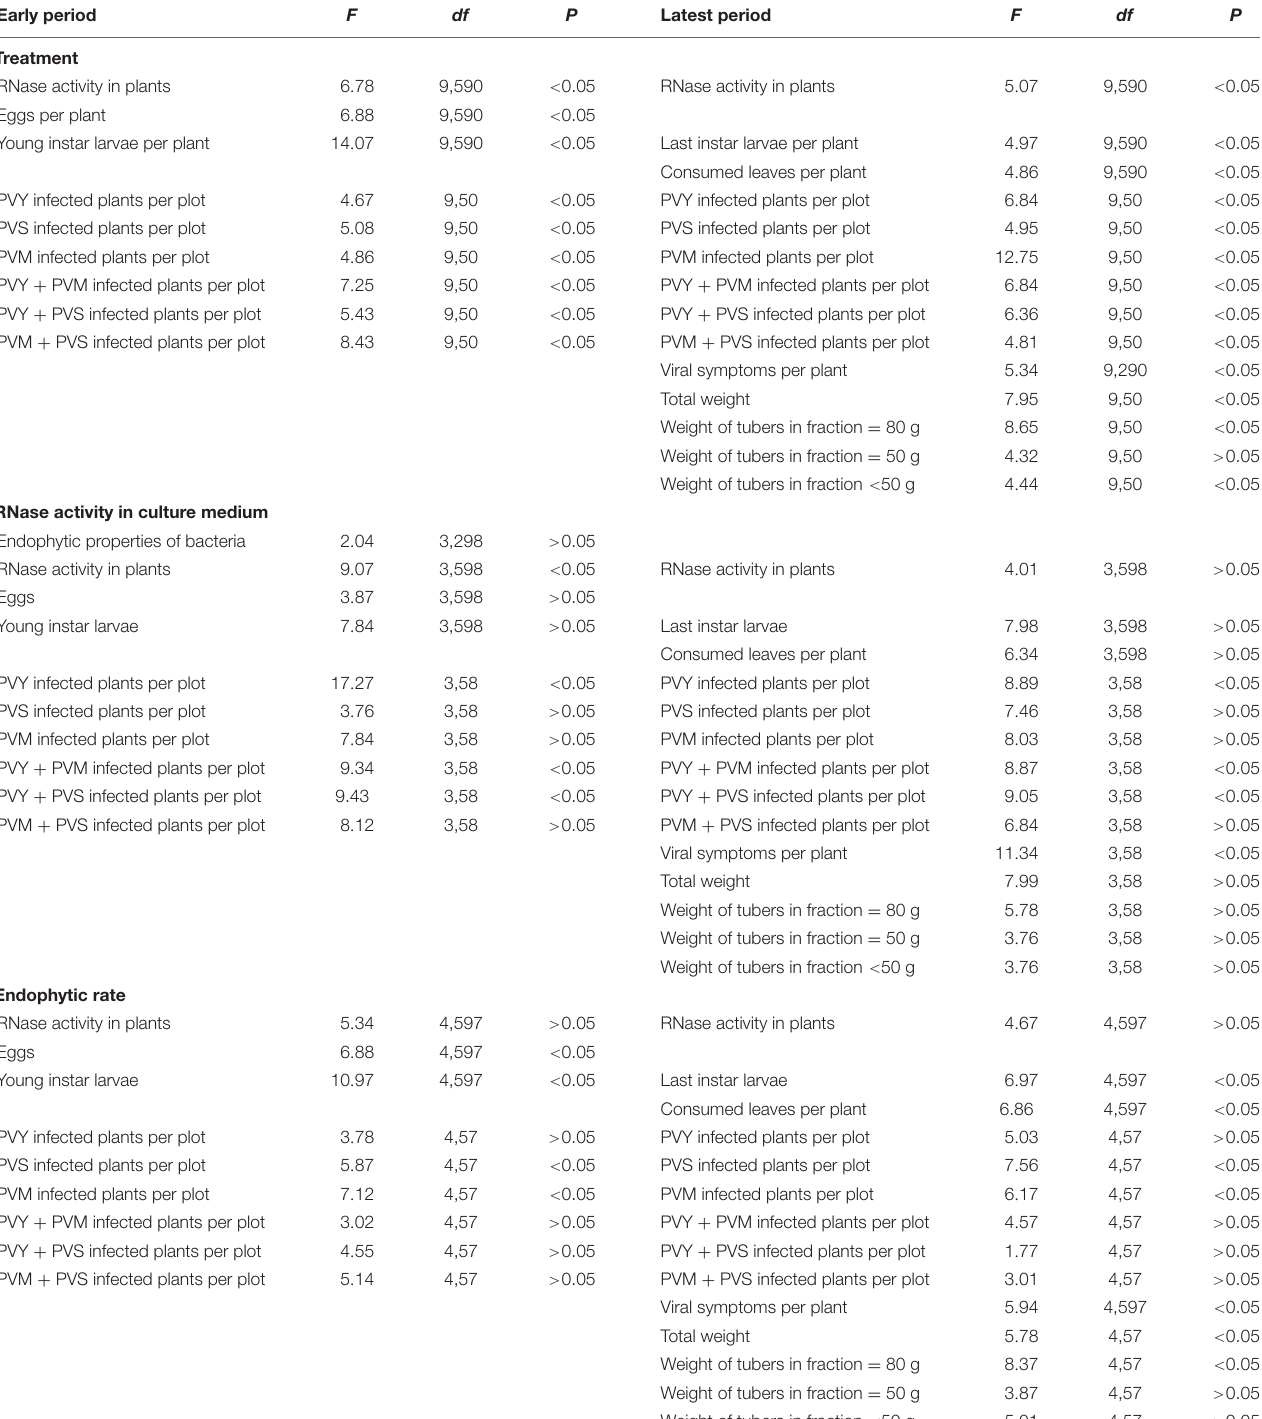
TABLE 4 | Statistical analysis of influence of treatment, RNase activity of strains and isolates and endophytic rate of strains and isolates on different parameters of potato plants under the field conditions. Early period F df P Latest period